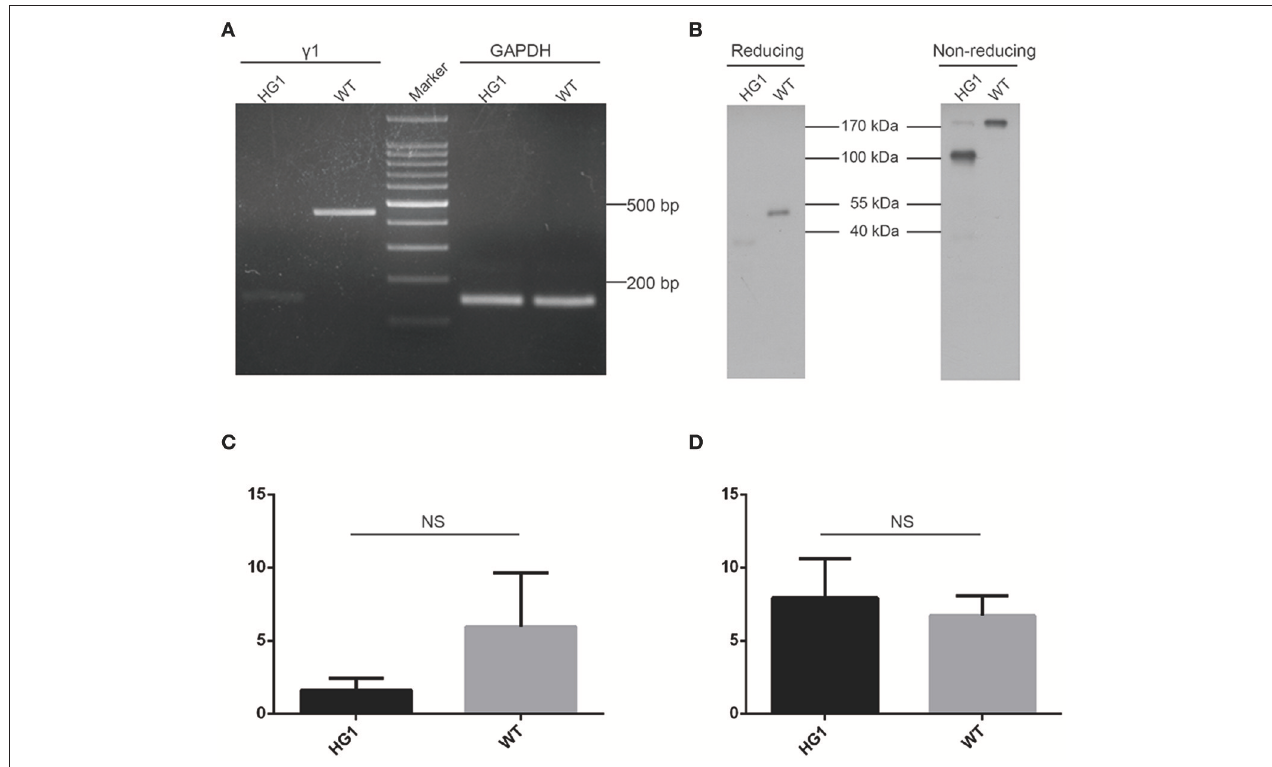
FIGURE 2 | Characterization of γ 1 gene expression in HG1 mice. (A) PCR detection of the γ 1 transcript in HG1 mice. (B) Western blotting showing IgG1 levels in the serum of HG1 mice. (C) qRT-PCR analysis of the transcription of the γ 1 gene in HG1 mice. (D) qRT-PCR analysis of the transcription of the µ gene in HG1 mice.